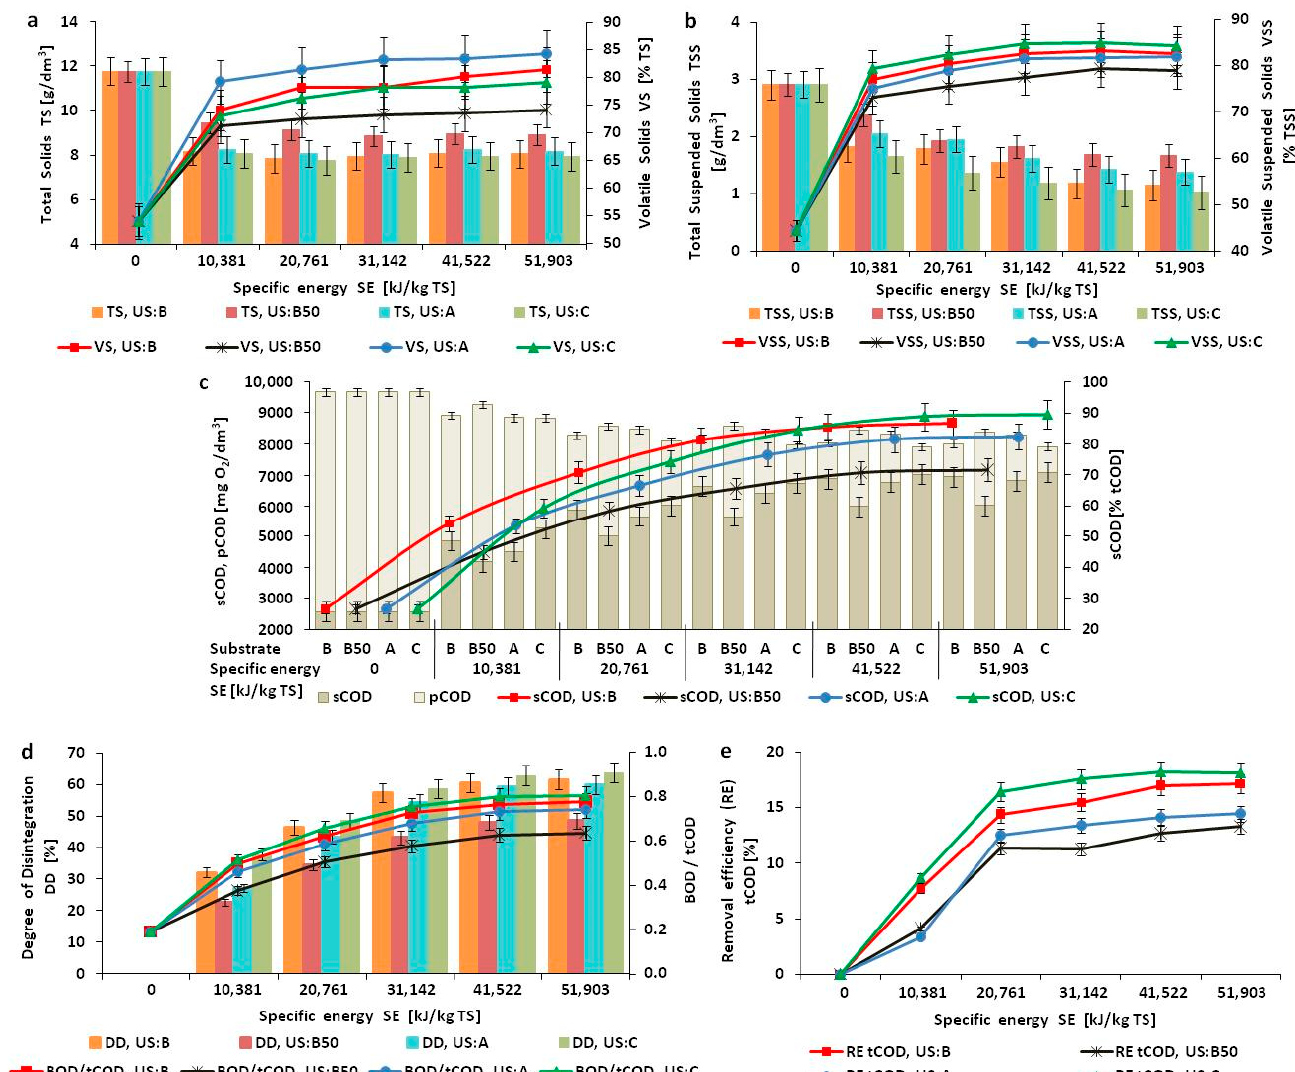
Figure 3. Effect of specific energy and initial pH of digestate liquid fraction on concentration of TS and VS ( a ), TSS and VSS ( b ), sCOD and pCOD ( c ); degree of disintegration and BOD/tCOD ratio ( d ); removal efficiency of tCOD ( e ) during ultrasonication of digestate liquid fraction.